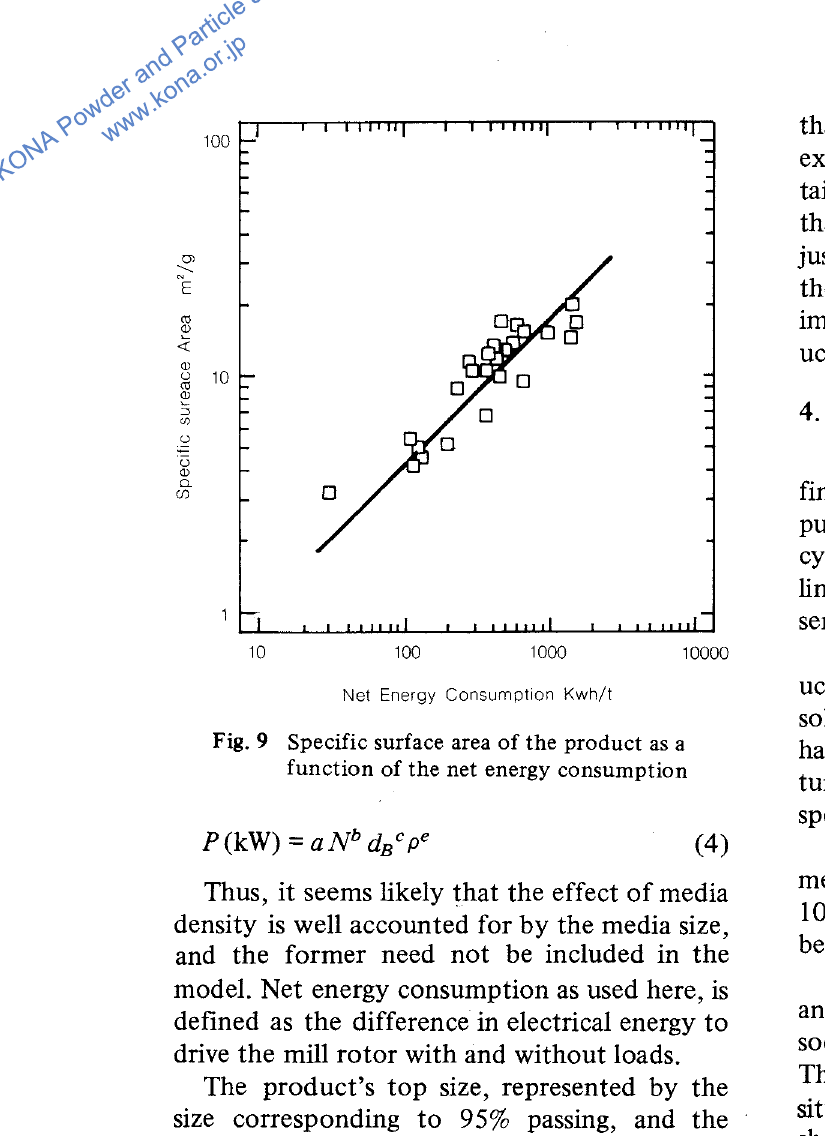
Fig. 9 Specific surface area of the product as a function of the net energy